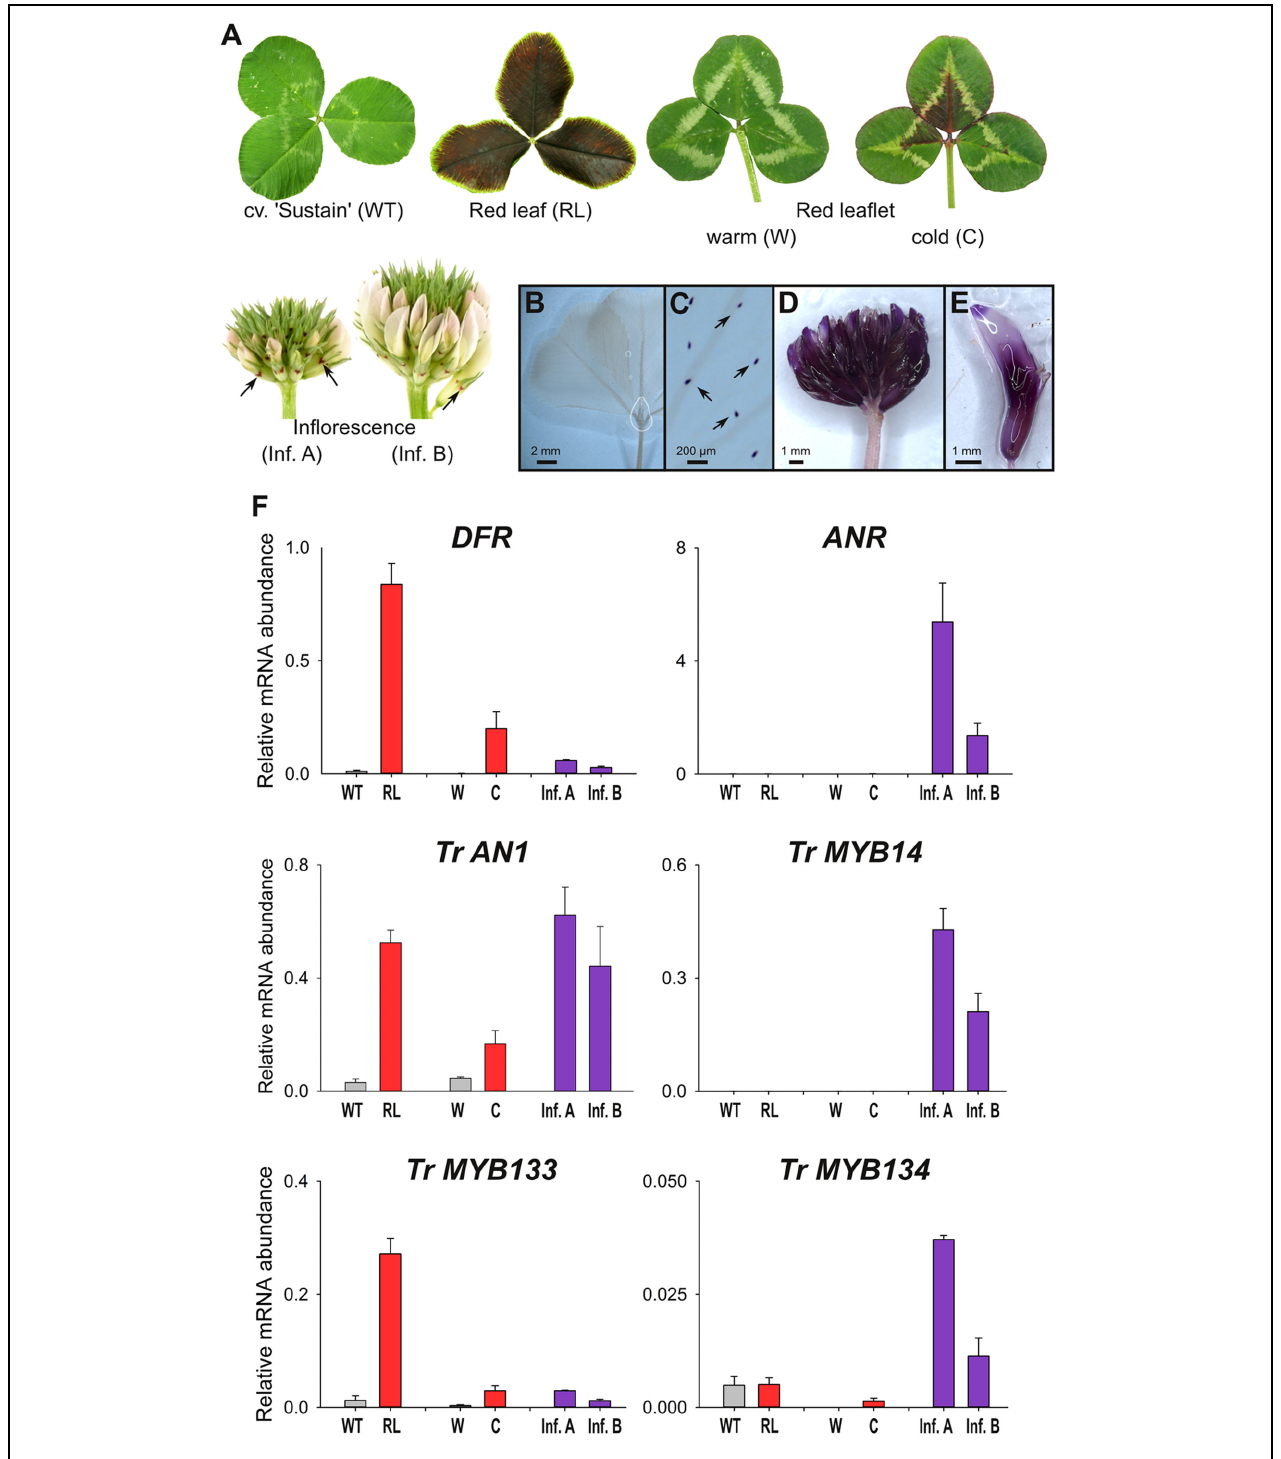
FIGURE 3 | MYB133 and MYB134 are expressed in tissues accumulating anthocyanin and proanthocyanidins. (A) Anthocyanin pigmentation phenotypes of samples used for qRT-PCR. White clover ‘Sustain’ (WT) lacks anthocyanins in leaves, while a genotype with the ‘Red leaf’ (RL) anthocyanin mark accumulates anthocyanins throughout the lamina. A genotype with the ‘Red leaflet’ trait lack anthocyanins when grown under warm conditions (W), but are induced with cold temperature (C). Inflorescences have low quantities of anthocyanins, although anthocyanin spots (arrows) are present on the calyx. ( B–E) Tissues stained with DMACA to detect proanthocyanidins (purple). (B) White clover leaves lack proanthocyanidins, except in their trichomes (C) . (D) Proanthocyanidins accumulate in inflorescences and (E) within individual florets. (F) Relative transcript abundance of genes involved in anthocyanin and proanthocyanidin synthesis and regulation was determined by qRT-PCR. Mean ± SEM n = 4 biological replicates is shown.